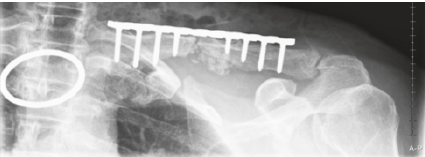
Figure 3: First day after implementation of plate osteosynthesis.